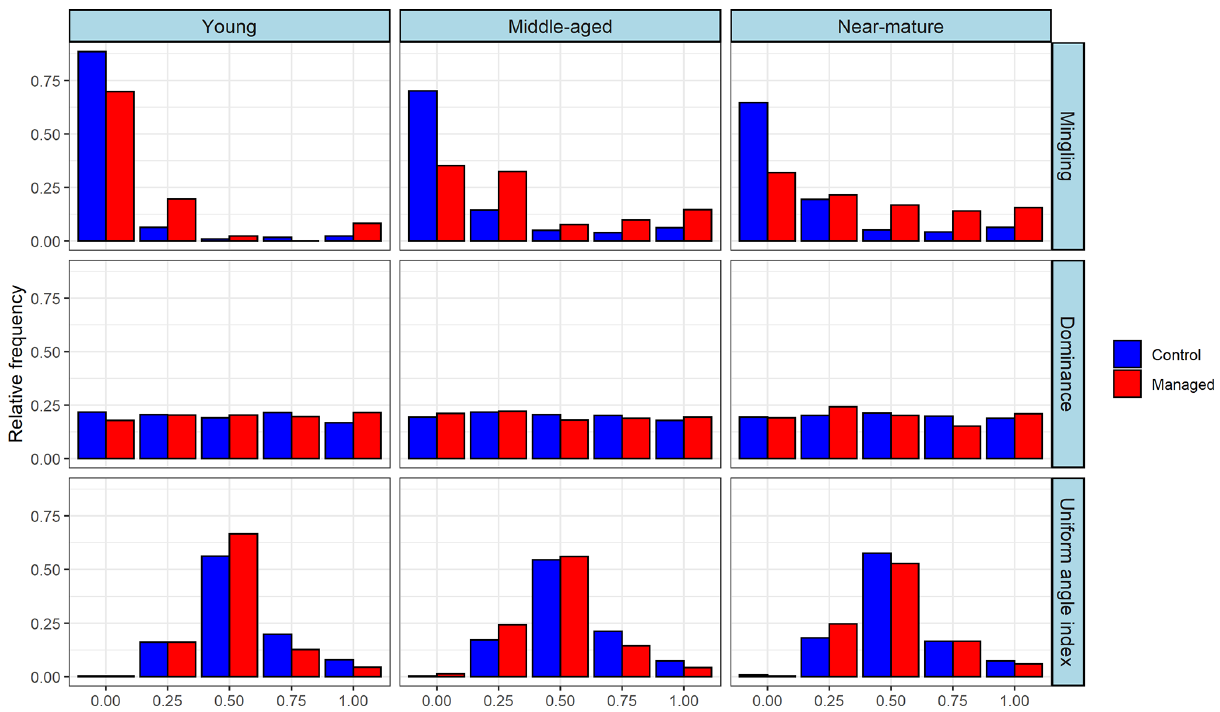
Figure 2. Frequency distribution of the spatial-structure parameters at different tree ages.